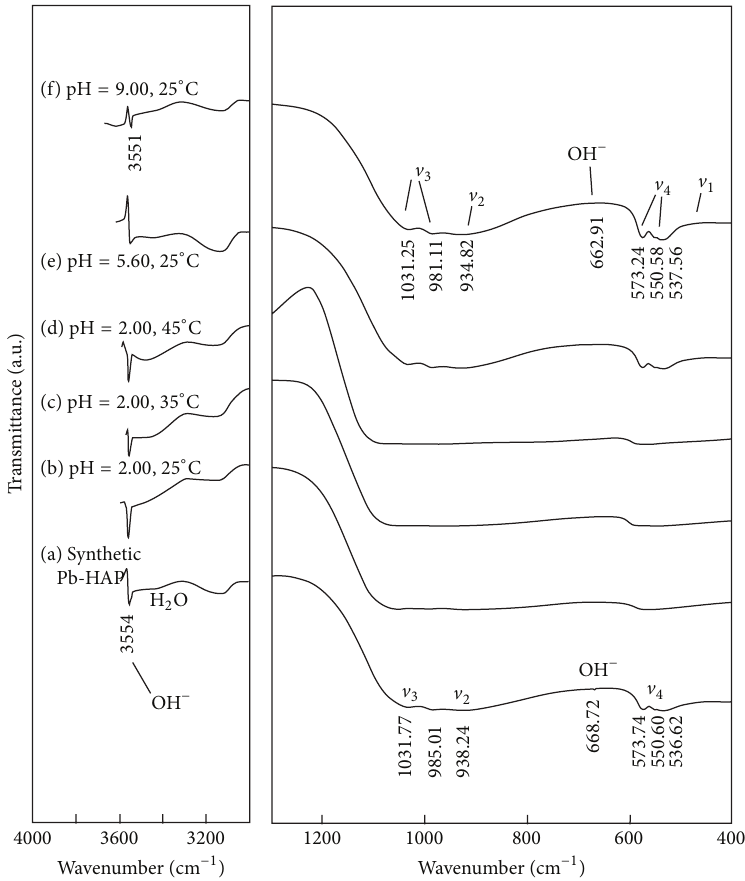
Figure 2: Fourier transform infrared (FT-IR) spectra of the synthetic lead hydroxypyromorphite [Pb 5 (PO 4 ) 3 OH] before (a) and after (b–f) dissolution at 25–45 ∘ C for 300